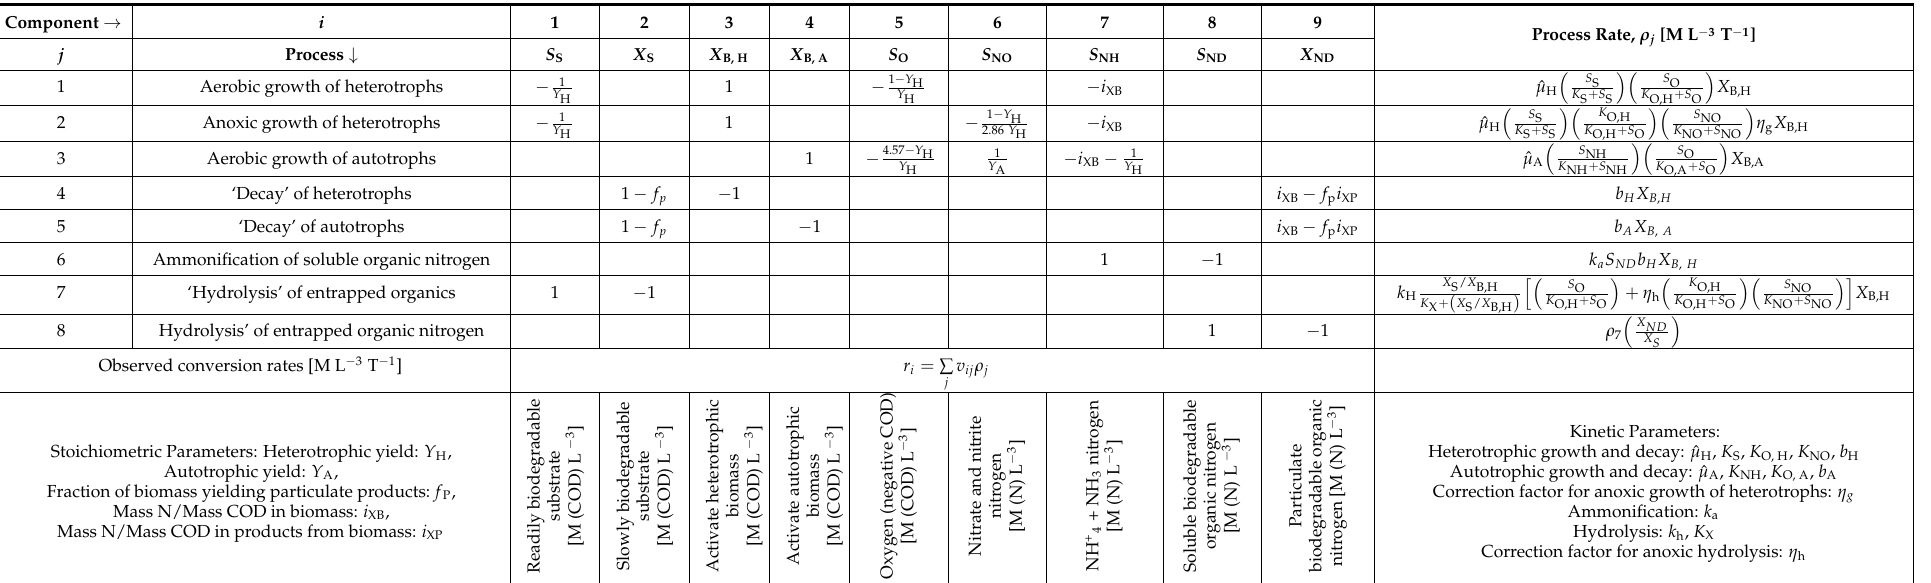
Table A2. Peterson matrix for the reduced ASM1 model with 9 state